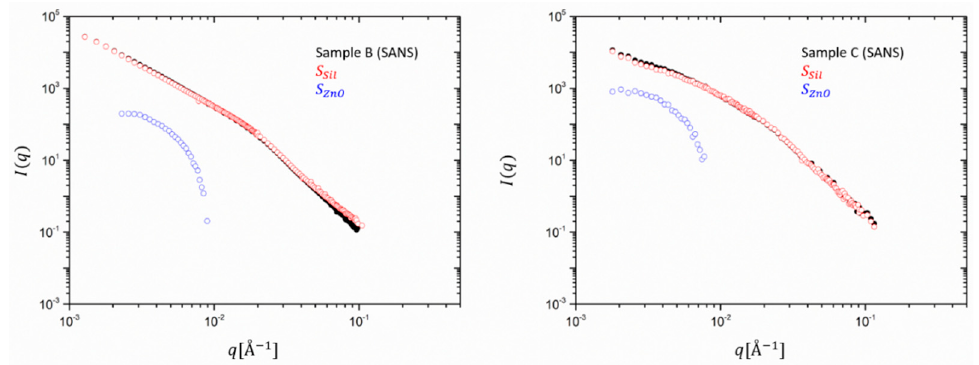
Figure 5. Experimental SANS data in absolute intensity units cm − 1 for samples B (30 phr) (left) and C (60 phr) (right). Partial form factors for silica ( S pol , red) and ZnO ( S ZnO , blue).